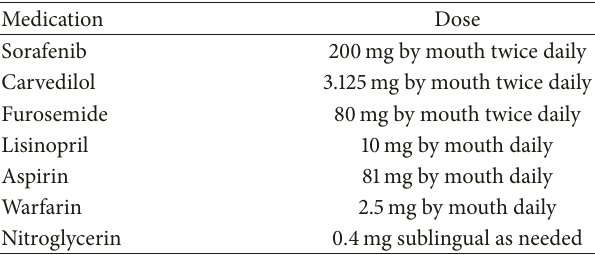
Table 1: The pertinent medication list and